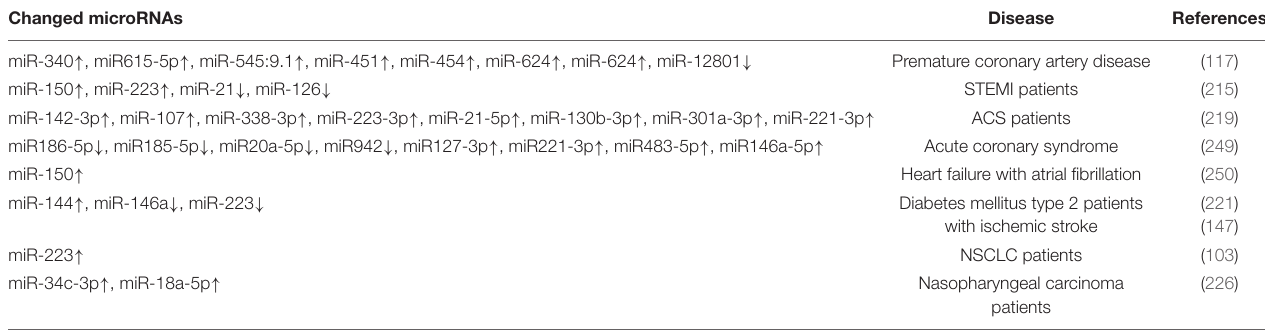
TABLE 5 | Changes of platelet miRNAs in cardiovascular disease and cancer. Changed microRNAs